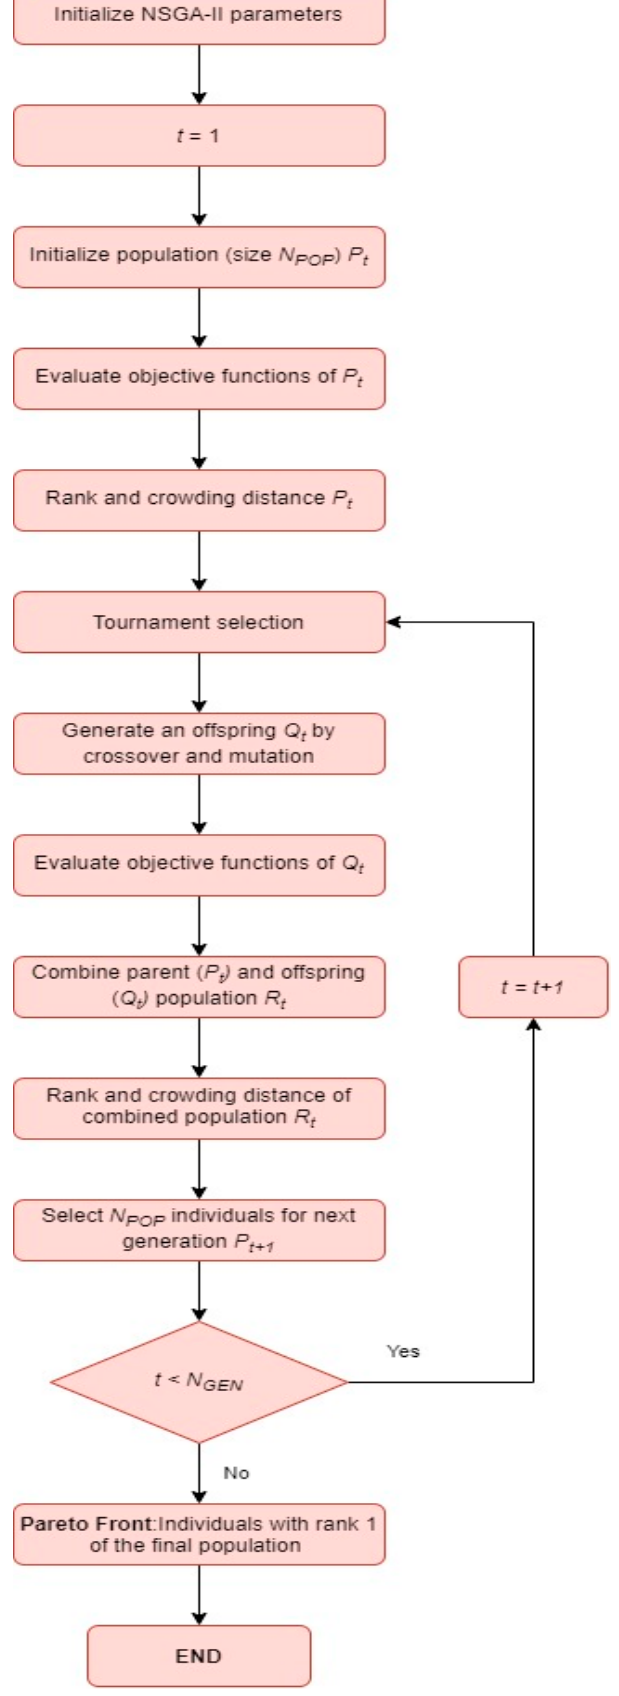
Figure 2. Flowchart of the nondominated sorting genetic algorithm (NSGA-II) algorithm.